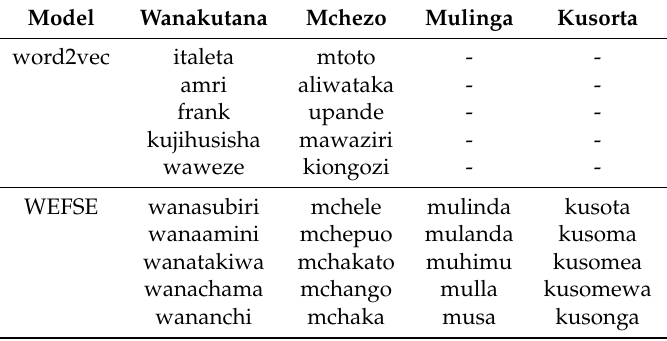
Table 7. The syntactically and semantically similar words using nearest neighbors.